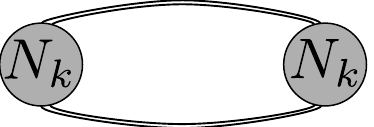
Figure 3: Quiver representation of the 4 d N = 1 Klebanov-Witten theory interpreted as a 3d N = 2 quiver with equal Chern-Simons